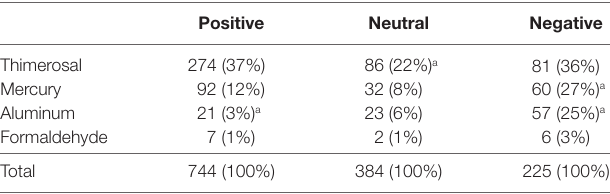
Table 7 | Main chemicals mentioned in webpages with different stance.